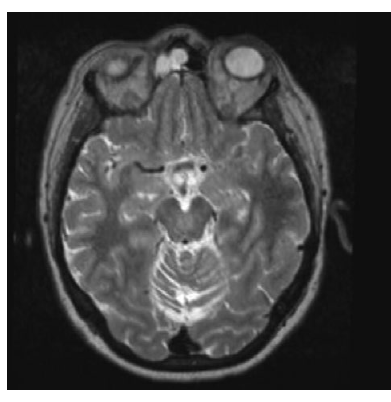
Figure 3. Same view as Figure 2. Artery has been mobilized away from the cerebral peduncle and decompressed using shred- ded PTFE felt.